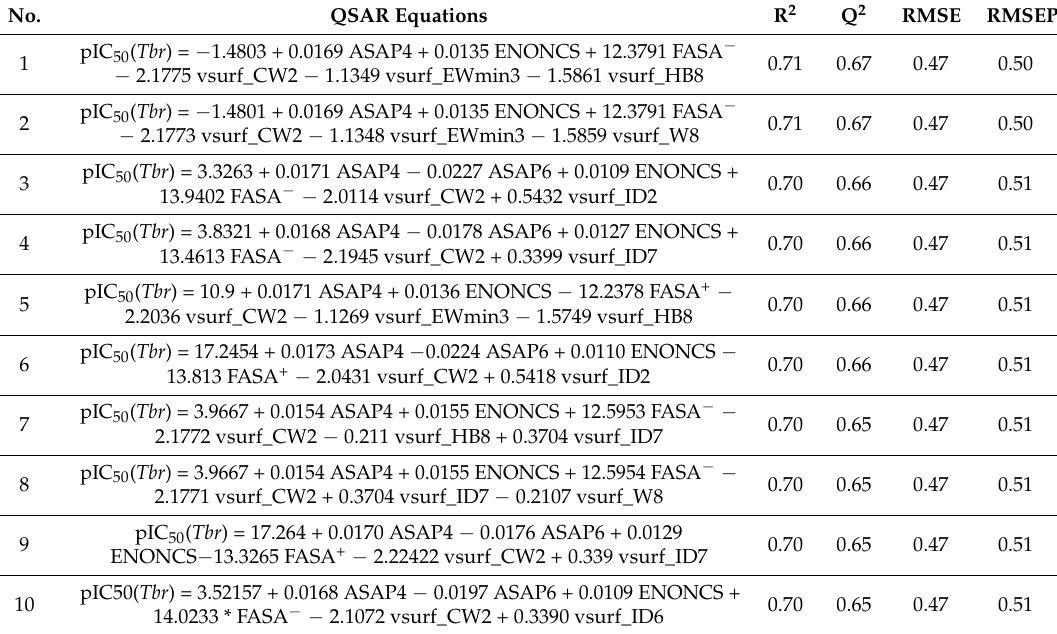
Table 2. The 10 best GA/MLR QSAR equations obtained in Model